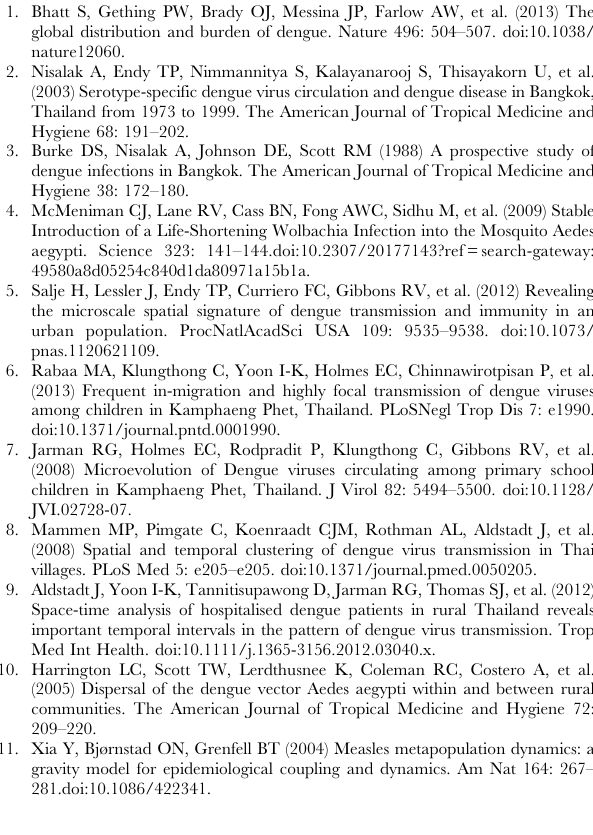
Figure S1 Short-term spatial dependence between cases within 5-year windows. Spatial dependence between cases occurring within the same month as measured through w (d 1 , d 2 ) where d 1 and d 2 is the distance range between cases. Individual estimates were generated using only cases from each 5-year window. The spatial range ( d 2 2 d 1 ) was kept constant at 1 km was equal to zero. Estimates are plotted at the midpoint of the spatial ranges. Figure S2 Correlation between epidemic curves using Spearman Rank coefficients. Box plots of the correlation between the epidemic curves of pairs of village clusters and